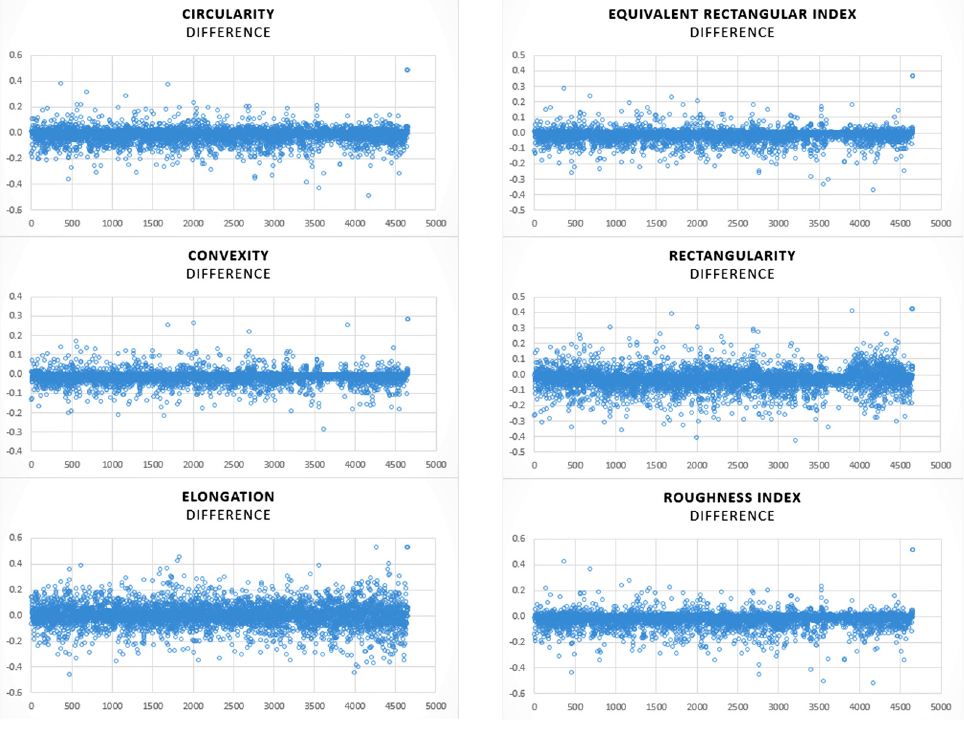
Fig. 8. Scatterplots of the shape element